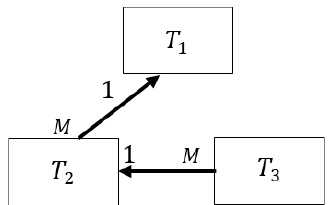
Figure 3. The relationship between the tables T 1 , T 2 and T 3 for the case when: (1) first table is the main, (2) the second table is simultaneously secondary for the first table and the main for the third table, and (3) the third table is secondary, related to the second